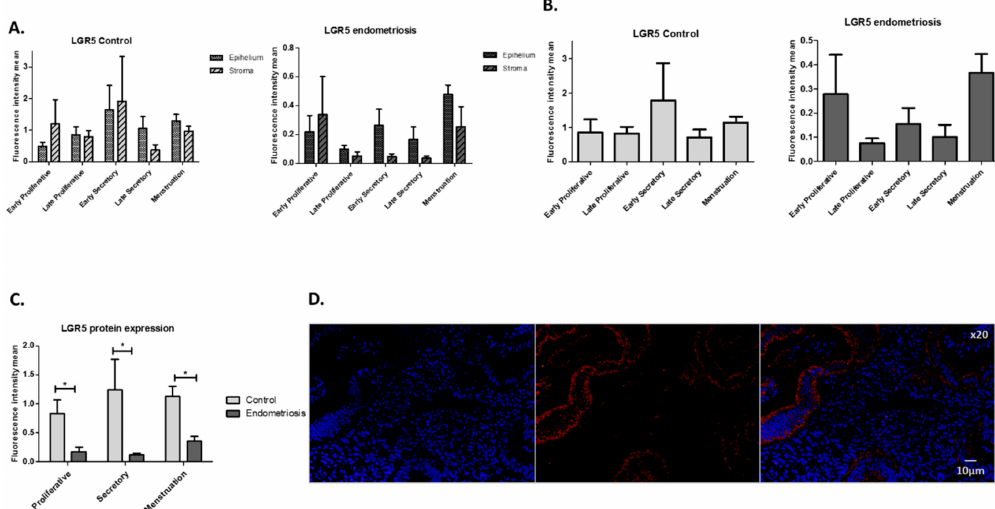
Figure 1. Immunofluorescence measurement of LGR5 expression throughout the menstrual cycle in eutopic endometrium. ( A ) Epithelial and stromal expression of LGR5 in control and endometriosis tissue in five phases of the menstrual cycle. ( B ) Total tissue expression across five phases of the menstrual cycle in control and endometriosis tissues. ( C ) Differences in LGR5 expression throughout the menstrual cycle between control and endometriosis tissue groups ( t -test for each phase; proliferative: p = 0.0242; secretory: p = 0.0424; menstruation: p = 0.0121). (Control: n = 24; endometriosis: n = 24). ( D ) Example of immunofluorescence of LGR5 in eutopic endometrium (early secretory phase). In blue: DAPI; in red: LGR5. * p <